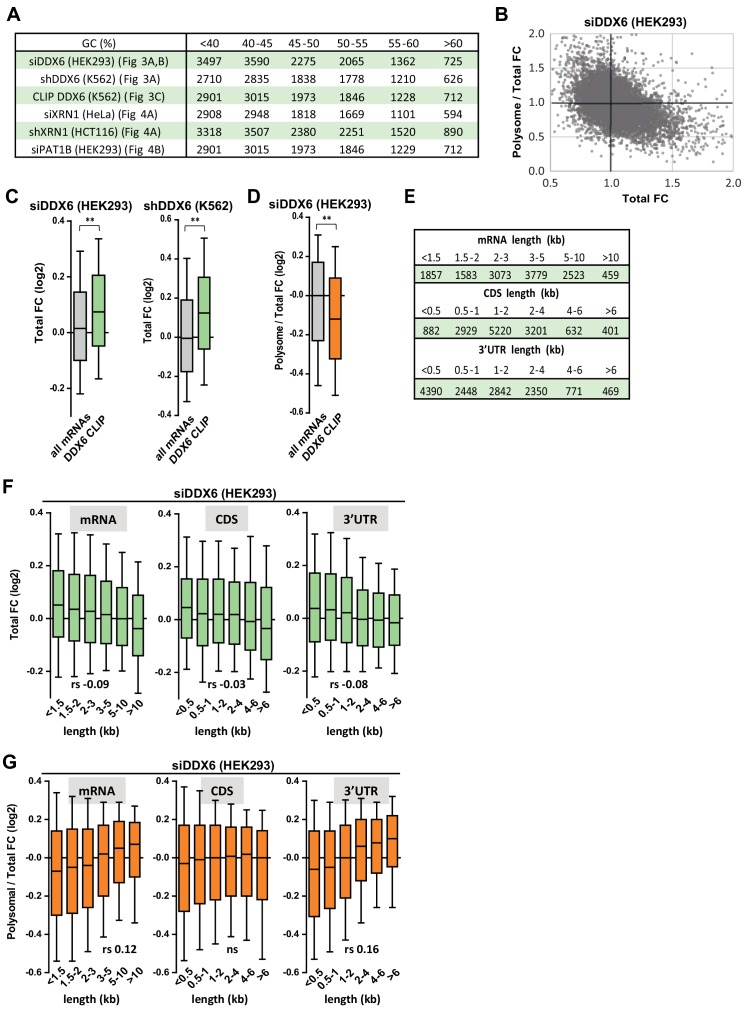
Impact of DDX6 binding and mRNA length on DDX6 dependency.(A) Number of transcripts in the different classes analyzed in Figures 3 and 4A,B. (B) Dot plot representation of the changes in translation rate (Polysome/Total FC) as a function of changes in mRNA stability (Total FC) after DDX6 silencing. (C,D) DDX6-clipped targets tend to be particularly stabilized after DDX6 silencing in both HEK293 and K562 cells (C), but less affected than other mRNAs in terms of translation rate (D). The difference between DDX6-clipped mRNAs and all mRNAs was statistically different using a two-tail Mann-Whitney test. **, p<0.0001. (E) Number of transcripts in the different classes analyzed in (F) and (G). (F) Transcript length has a weak impact on mRNA abundance following DDX6 silencing. Transcripts were subdivided into six classes depending on their full length (from <1.5 to 10 kb, left panel), the length of their CDS (from <0.5 to 6 kb, middle panel) or 3’UTR (from <0.5 to 6 kb, right panel). The boxplots represent the distribution of their respective fold-changes in total mRNA. The difference between class 1 and 6 was statistically significant using a two tail Mann-Whitney test: p<0.0001 in all panels. rs, Spearman correlation coefficient. (G) The 3’UTR length has an impact on mRNA translation derepression following DDX6 silencing. The polysomal/total mRNA ratio was used as a proxy measurement of translation rate.The data are represented as in (F). Note that the difference between class 1 and 6 was statistically significant in left and right panels only.